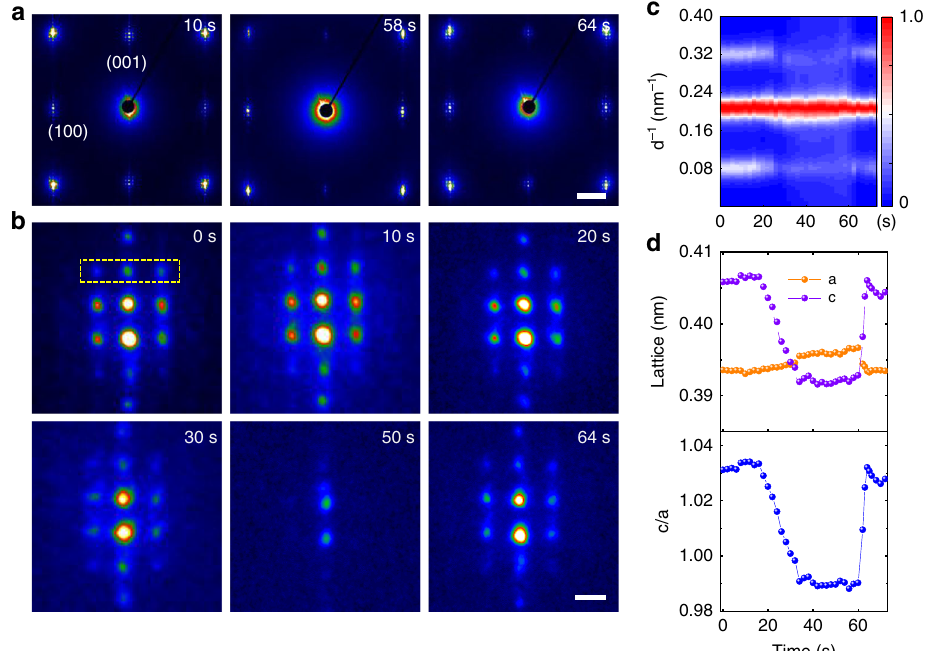
Fig. 3 Structural evolution of vortices under mechanical stress. a Three SAED images extracted from a real-time image series corresponding to before, during, and after mechanical loading. The vortex re fl ections disappear at 58 s and recover when the external stress is removed at 64 s. Scale bar, 2 nm − 1 . b Chronological SAED (001) pc images with vortex spots dimming as the mechanical force is continuously applied. Yellow box at 0 s indicates diffraction spots used in c . Scale bar, 0.1 nm − 1 . c Line pro fi le intensity as a function of time normalized by the center superlattice spots. d The in-plane a and out-of- plane c lattice parameters and c / a ratio as functions of time. The c / a ratio is eventually less than 1 under a continuously applied mechanical load, indicating that the vortices have transformed to a